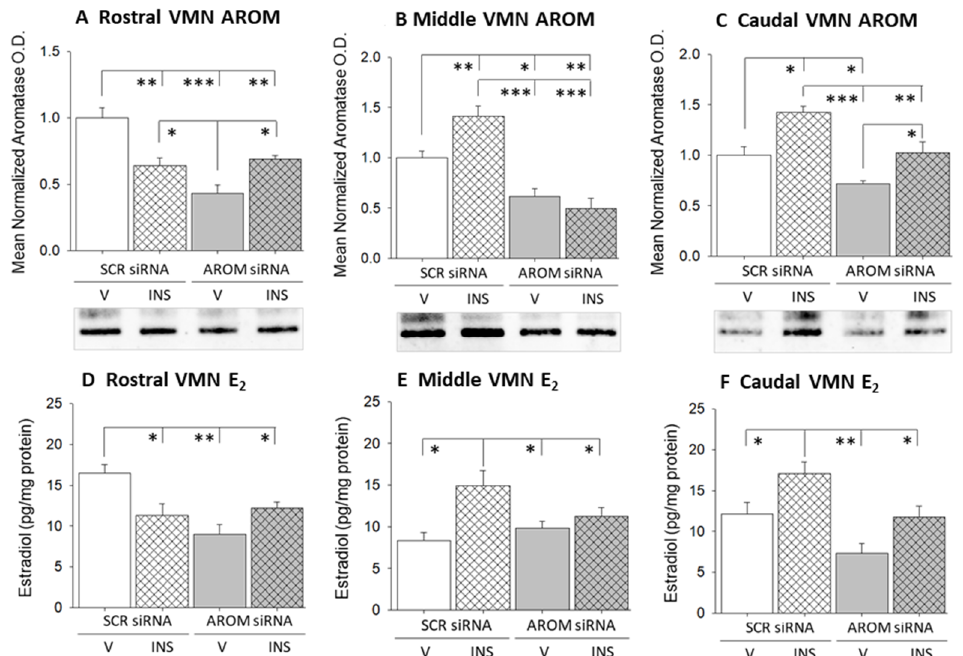
Figure 1. Effects of Intra-Ventromedial Hypothalamic Nucleus (VMN) Aromatase siRNA Admin- istration on Tissue Aromatase Protein and Estradiol Content in Euglycemic and Hypoglycemic Male Rats. Bilateral, micropunched samples from rostral, middle, and caudal VMN were obtained from groups of scramble (SCR) or aromatase (AROM) siRNA-pretreated male rats 1 h following subcutaneous (sc) injection of vehicle (V) or neutral protamine Hagedorn insulin (INS; 10 U/kg bw ). ( A – C ) show mean normalized rostral, middle, and caudal VMN aromatase protein optical density (O.D.) measures + S.E.M., respectively, for SCR siRNA/V (solid white bar; n = 4), SCR siRNA/INS (diagonal-striped, white bar; n = 4), and AROM siRNA/V (solid gray bar; n = 4), AROM siRNA/INS (diagonal-striped gray bar; n = 4) treatment groups. ( D – F ) depict mean rostral, middle, and caudal VMN tissue estradiol concentrations + S.E.M. after V or INS injection to SCR versus aromatase siRNA-pretreated animals. * p < 0.05; ** p < 0.01; *** p < 0.001.